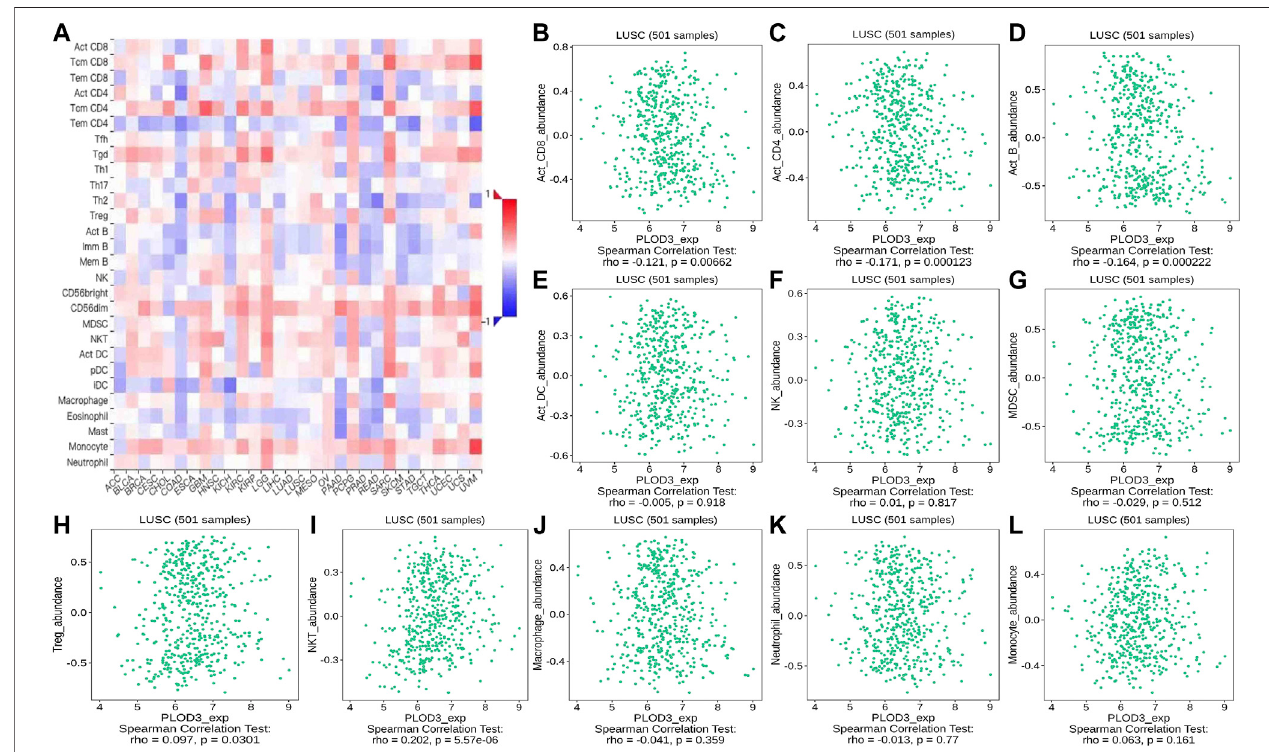
FIGURE 14 | Correlation of PLOD3 expression with TILs. (A) Heatmap of PLOD3 expression in pan-cancer from the TISIDB database. (B – L) PLOD3 expression level is signi fi cantly correlated with in fi ltrating levels of activated CD8 + T cells, activated CD4 + T cells, activated B cells, Treg cells, and NKT cells.